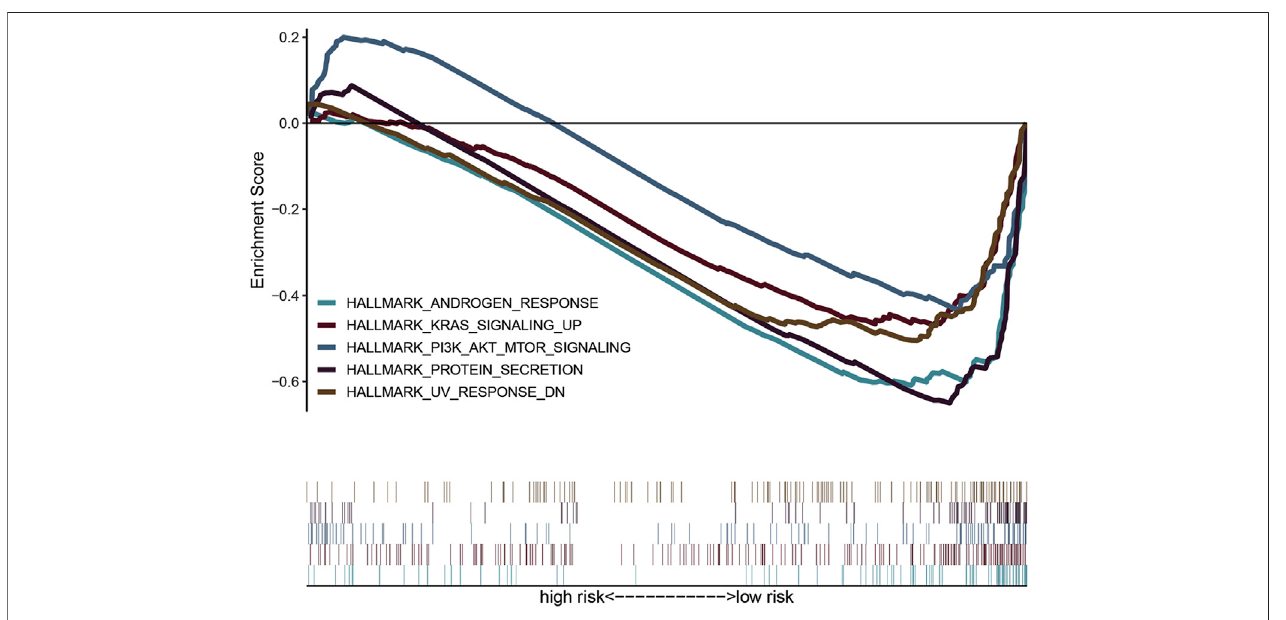
FIGURE 6 | Gene set variation analysis and gene set enrichment analysis of pathways. GSEA showed fi ve pathways enriched in the low-risk group.